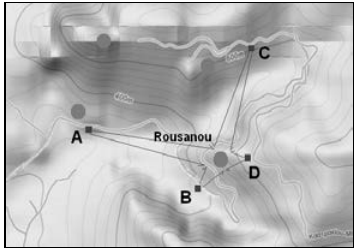
Table 1. Technical details of the equipment.